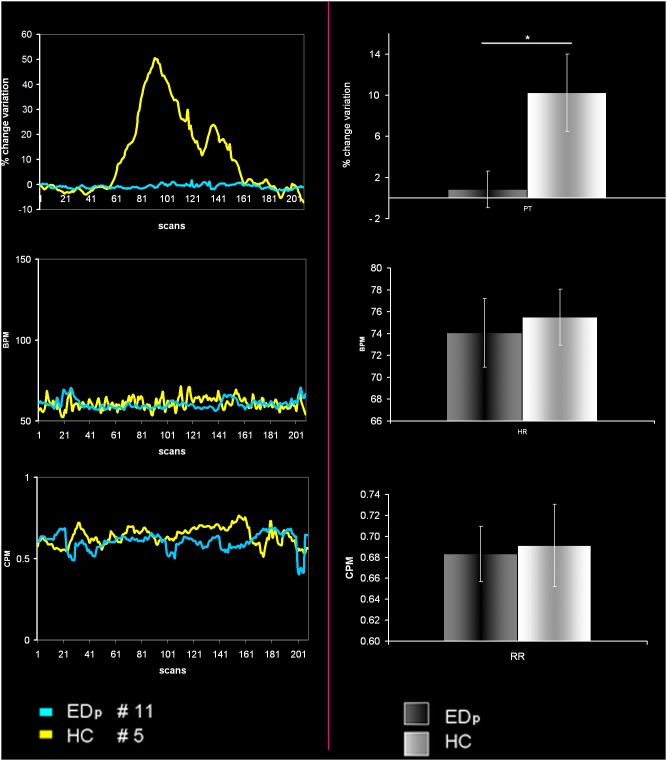
Physiological results.Left side: Example of time courses of penile reaction as recorded by the penile tumescence measuring device, heart and respiratory rate respectively for the HC number 5 and EDp number 11. Right side: histograms show averaged between group differences in penile tumescence, heart and respiratory rate respectively. Only penile tumescence shows significant differences with p<0.05. Vertical bars denote standard errors of mean (SEM).